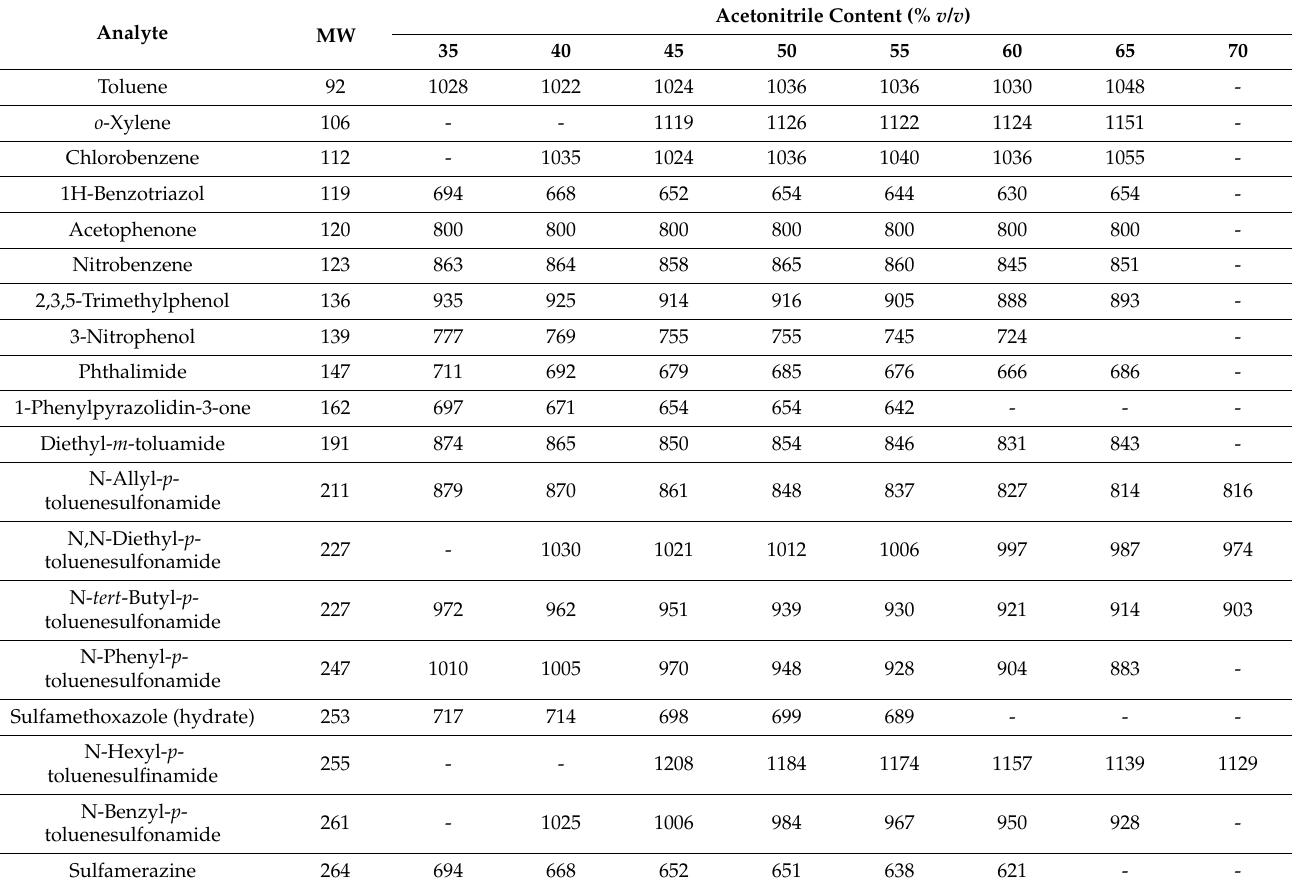
Table 3. Retention indices of some organic compounds depending on the acetonitrile content in the